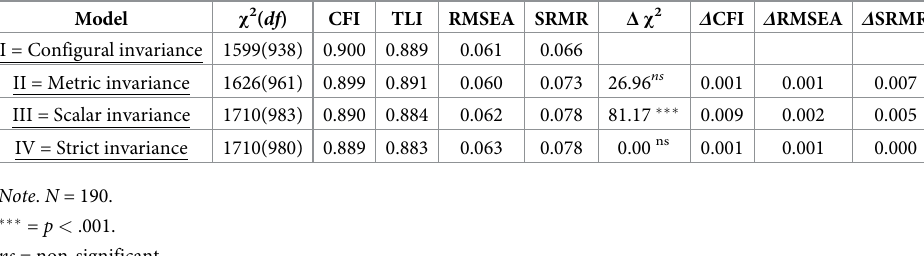
Table 7. Measurement invariance: Multi-measurement CFA fit indices (Study 2,